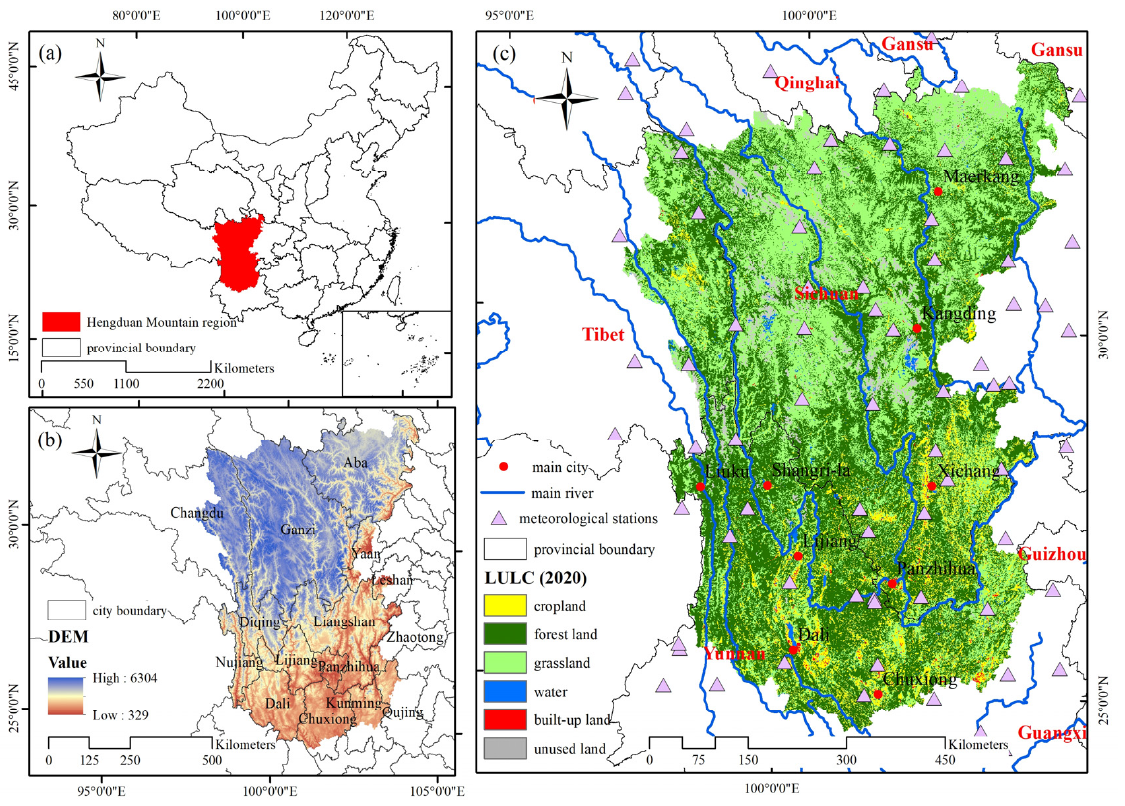
Figure 1. Basic information of the Hengduan Mountain region. ( a ) Location, ( b ) DEM, and ( c ) LULC map